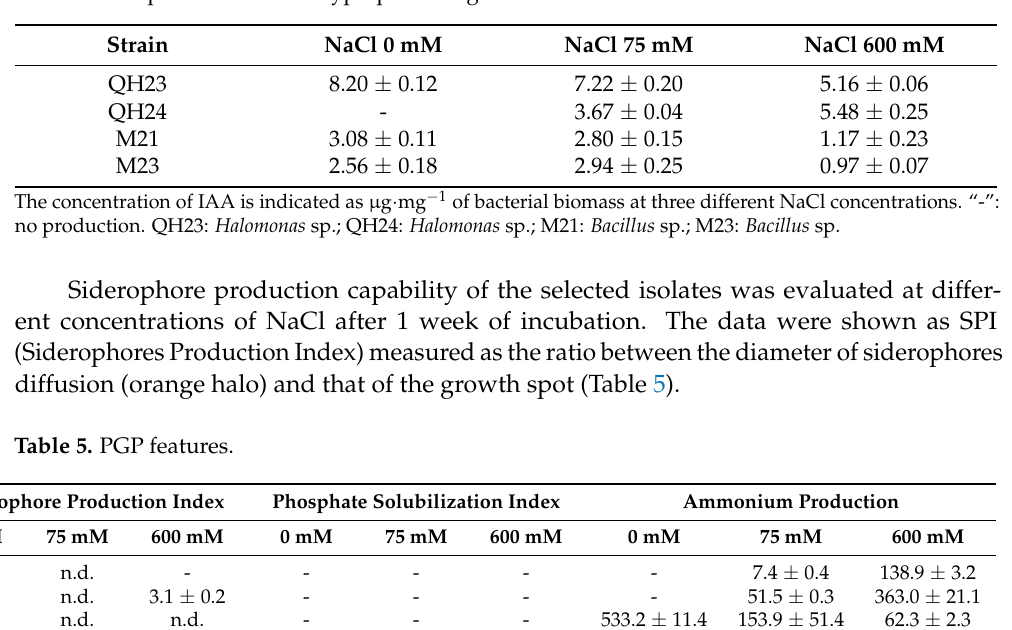
Table 4. IAA production with tryptophan 0.5 g · L − 1 .